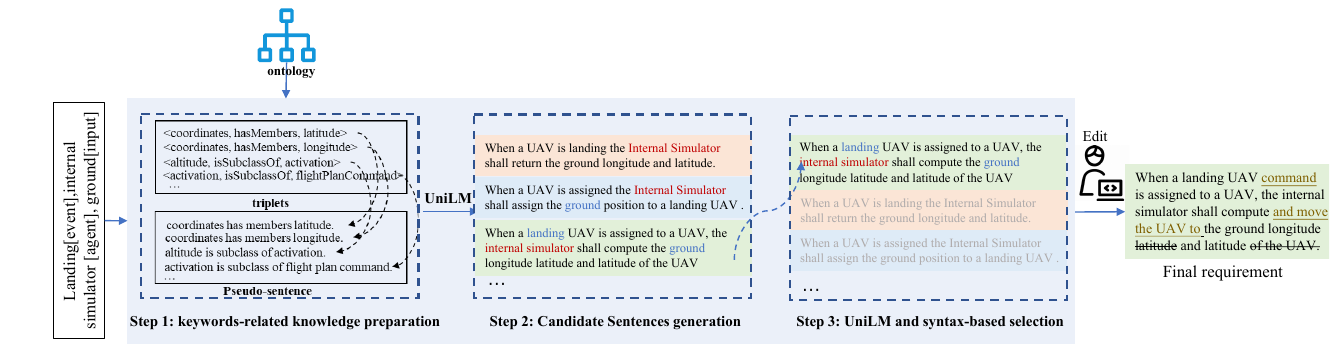
Figure 1. One example showing the target of this